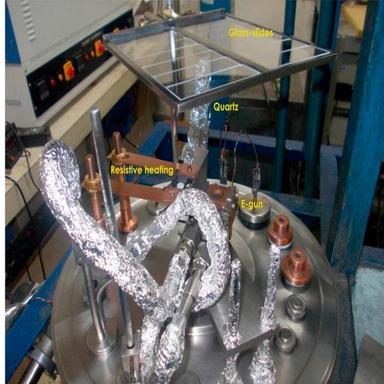
The inner view of DPU thermal evaporation chamber.